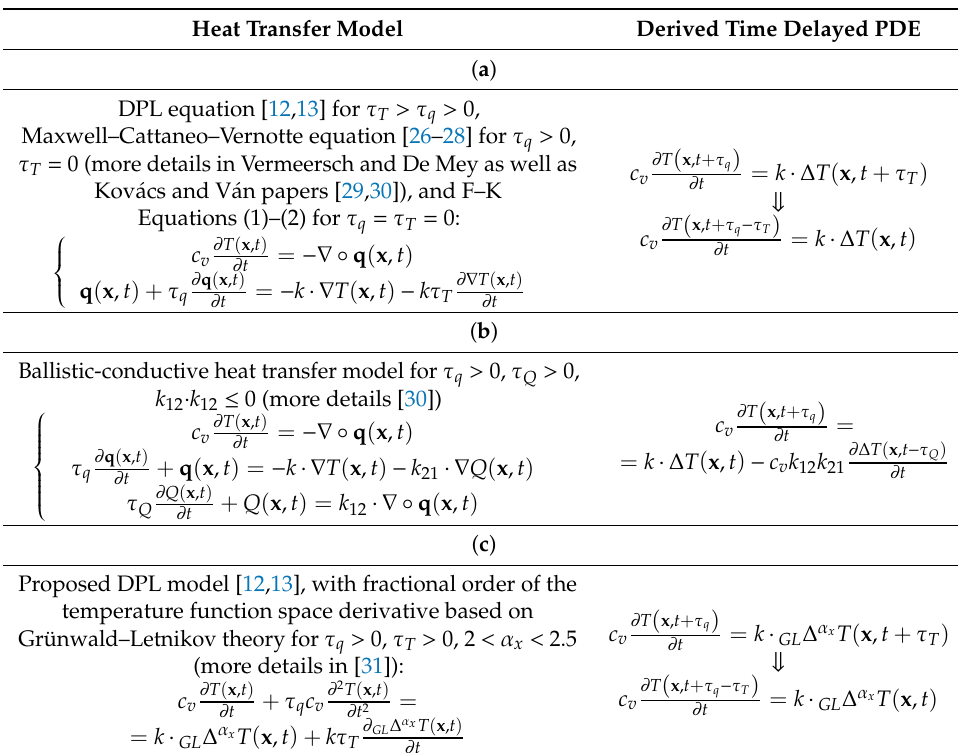
Table 1. Selected Heat Transfer Model transformed into time delayed Partial Di ff erential